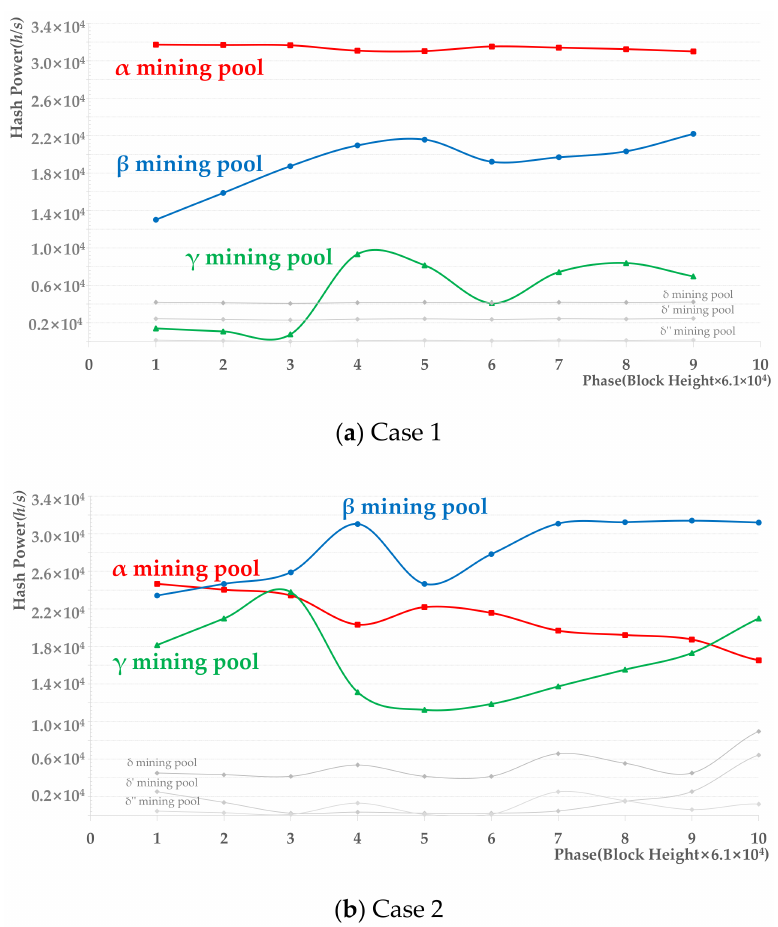
Figure 10. Mining Competition in Each Experimental Case: ( a ) Case 1; ( b ) Case